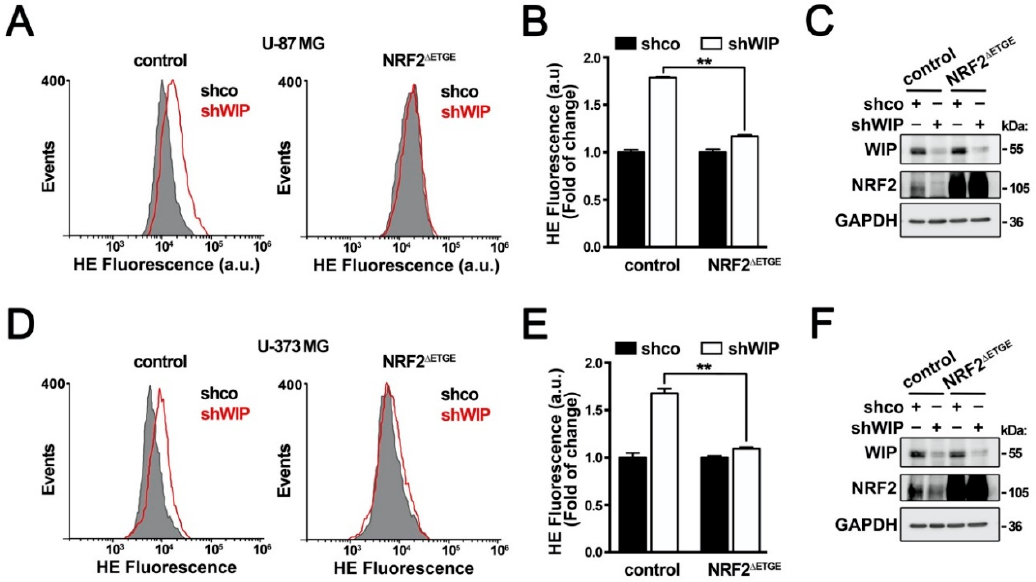
Figure 3. The regulation of redox state by WIP is NRF2-dependent. ( A – C ) U-87 MG and ( D – F ) U-373 MG glioblastoma cells were transduced with empty lentiviral as control or a lentivirus expressing NRF2 ∆ ETGE , and then with a lentivirus expressing shco or shWIP. ( A , D ) Changes in intracellular ROS were determined by flow cytometry of HE staining (a.u., arbitrary units of fluorescence emission). A representative sample of 10,000 cells is shown for each condition. ( B , E ) Quantification of intracellular ROS production in HE-stained (a.u., arbitrary units of fluorescence emission) ( n = 3). Data are presented as mean ± S.D. ** p ≤ 0.01 according to one-way ANOVA. ( C , F ) Representative immunoblots of WIP, NRF2, and GAPDH as a loading control.